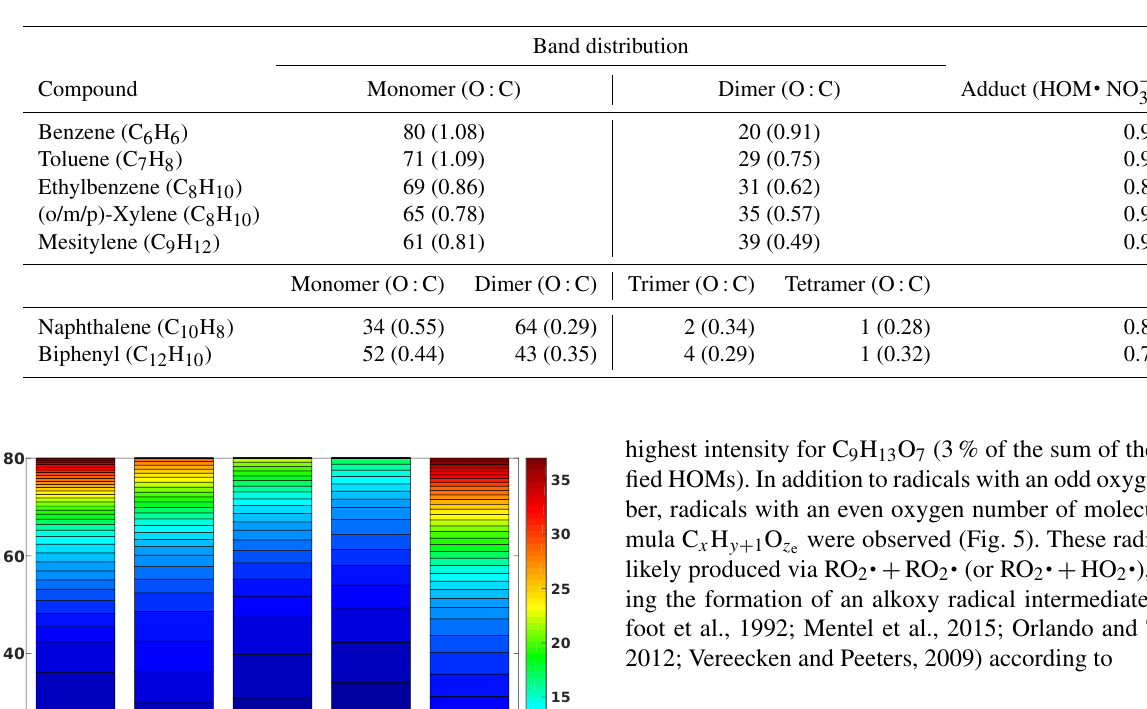
Table 2. Summary of HOM characteristics. For each of the seven compounds the percentage fractional distribution of the signal is presented. For monocyclic compounds the distribution comprises monomers and dimers; for naphthalene and biphenyl, monomers, dimers, trimers, and tetramers are reported. These values are not quantitative as the instrument cannot be calibrated for such compounds. For each band the weighted arithmetic means of the O:C ratio are reported in parentheses. The fraction of the identified peaks as adduct with NO − the last column.